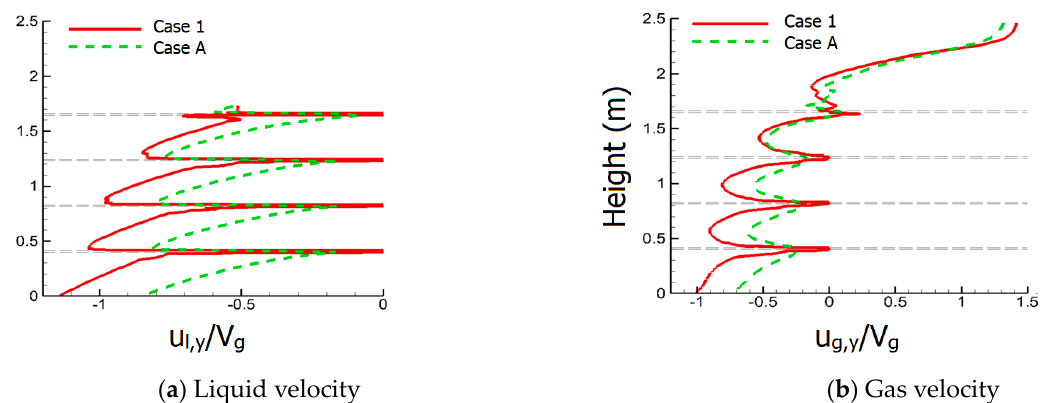
Figure 8. This figure displays the liquid and gas flow velocity along the centerline of the small-scale tower for Case 1 and